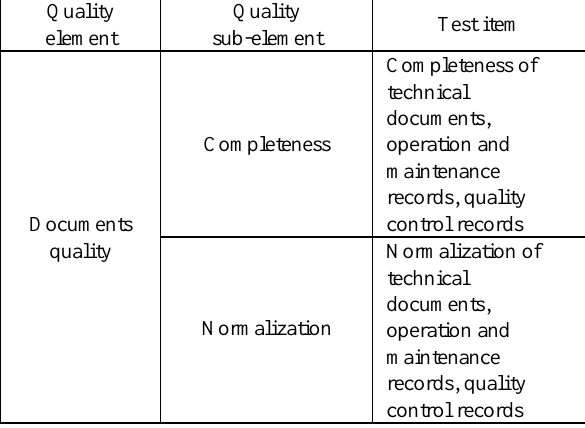
Table 3. List of quality elements, quality sub-elements and test items for documents